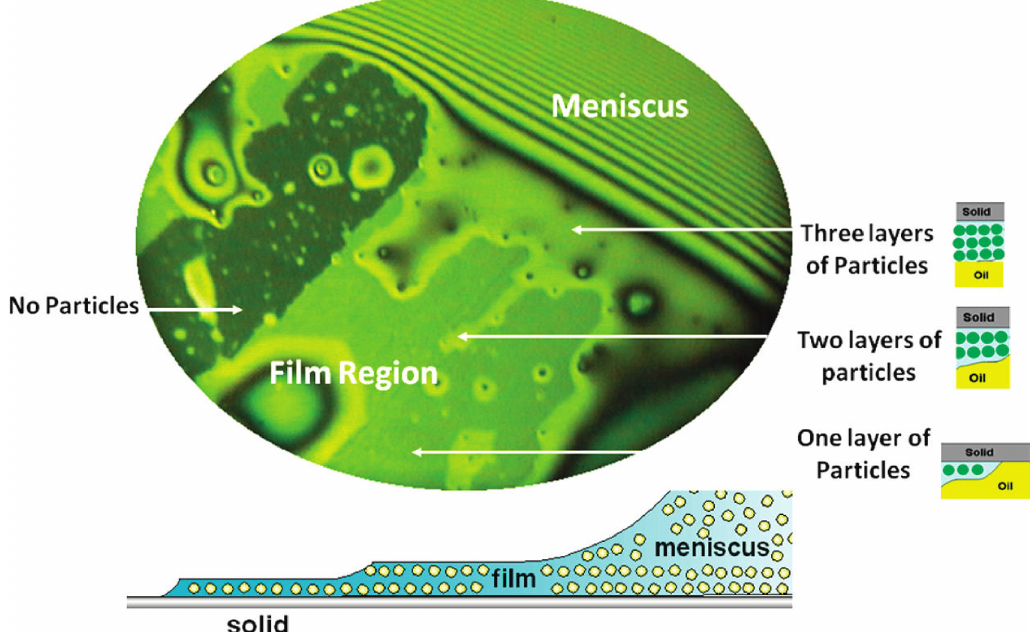
Figure 11. Photomicrograph depicting particle layering of 10 vol % aqueous silica nanofluid with a particle diameter d = 19 nm on a solid surface (film size = 868 µ m). Figure reproduced from Ref.